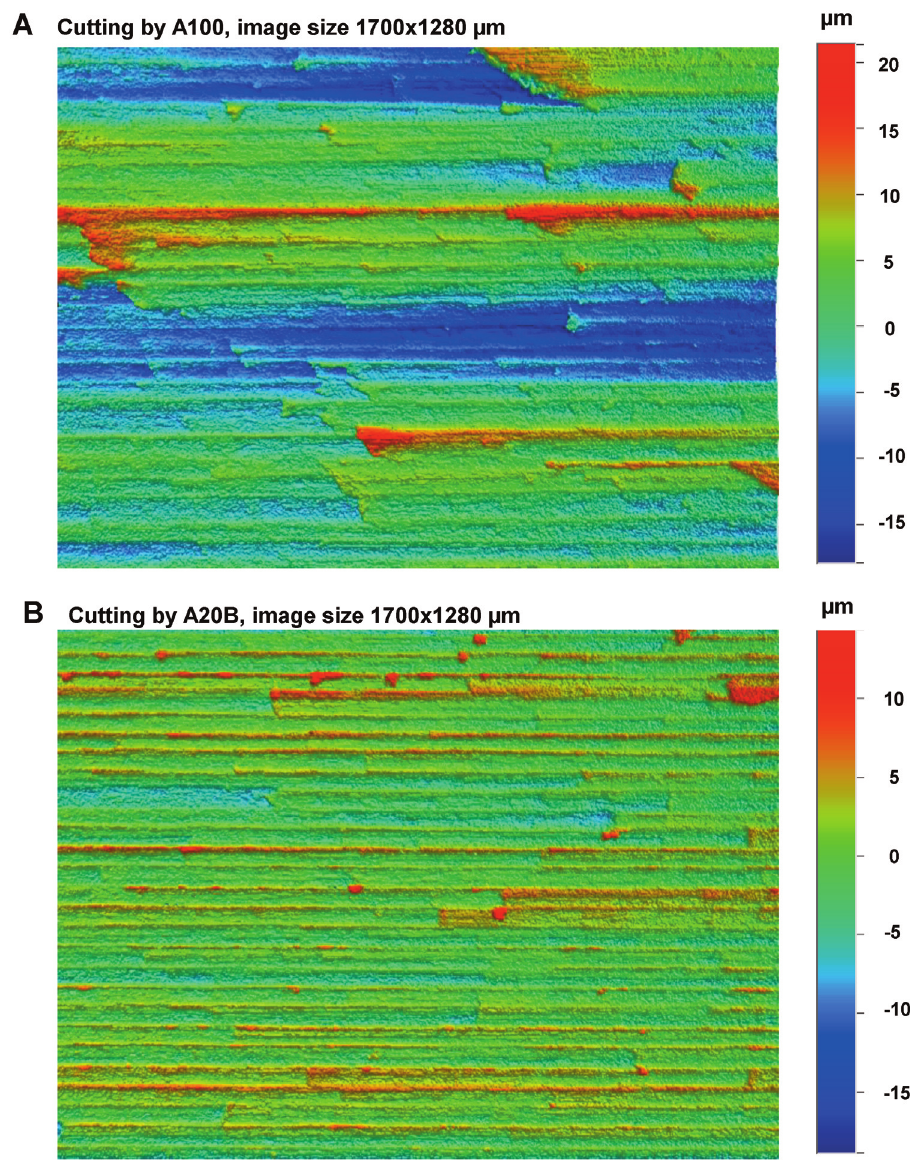
Fig. 6. 3D exemplary images of the workpiece surface after the cutting test by A100 and